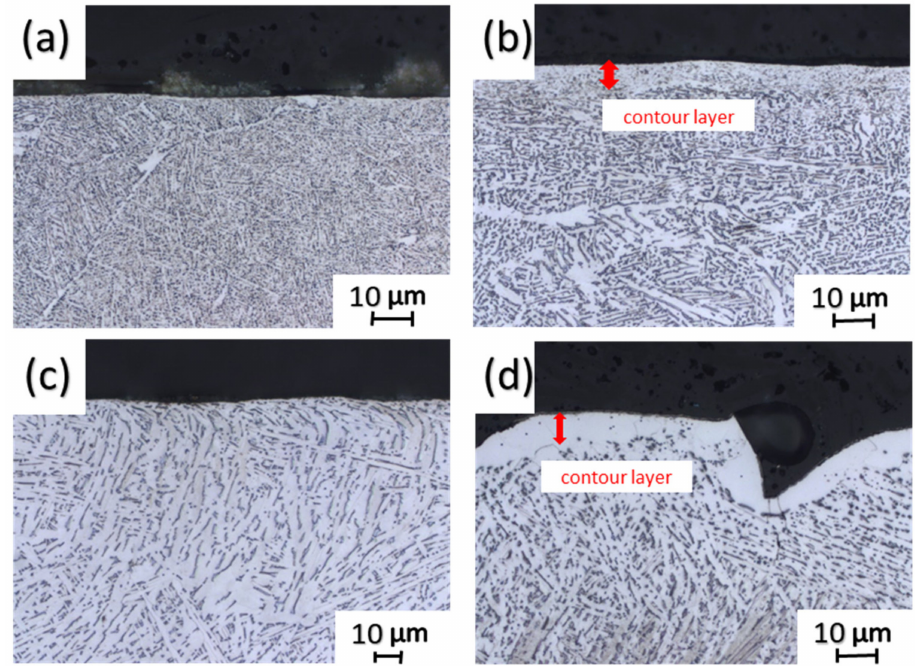
Figure 12. Surface of the samples in longitudinal direction: ( a ) EBM machined, flat sample in ZXY direction, ( b ) EBM as-deposited, flat sample in ZXY direction, ( c ) SLM machined, flat sample in ZXY direction and ( d ) SLM as-deposited, flat sample in ZXY direction.